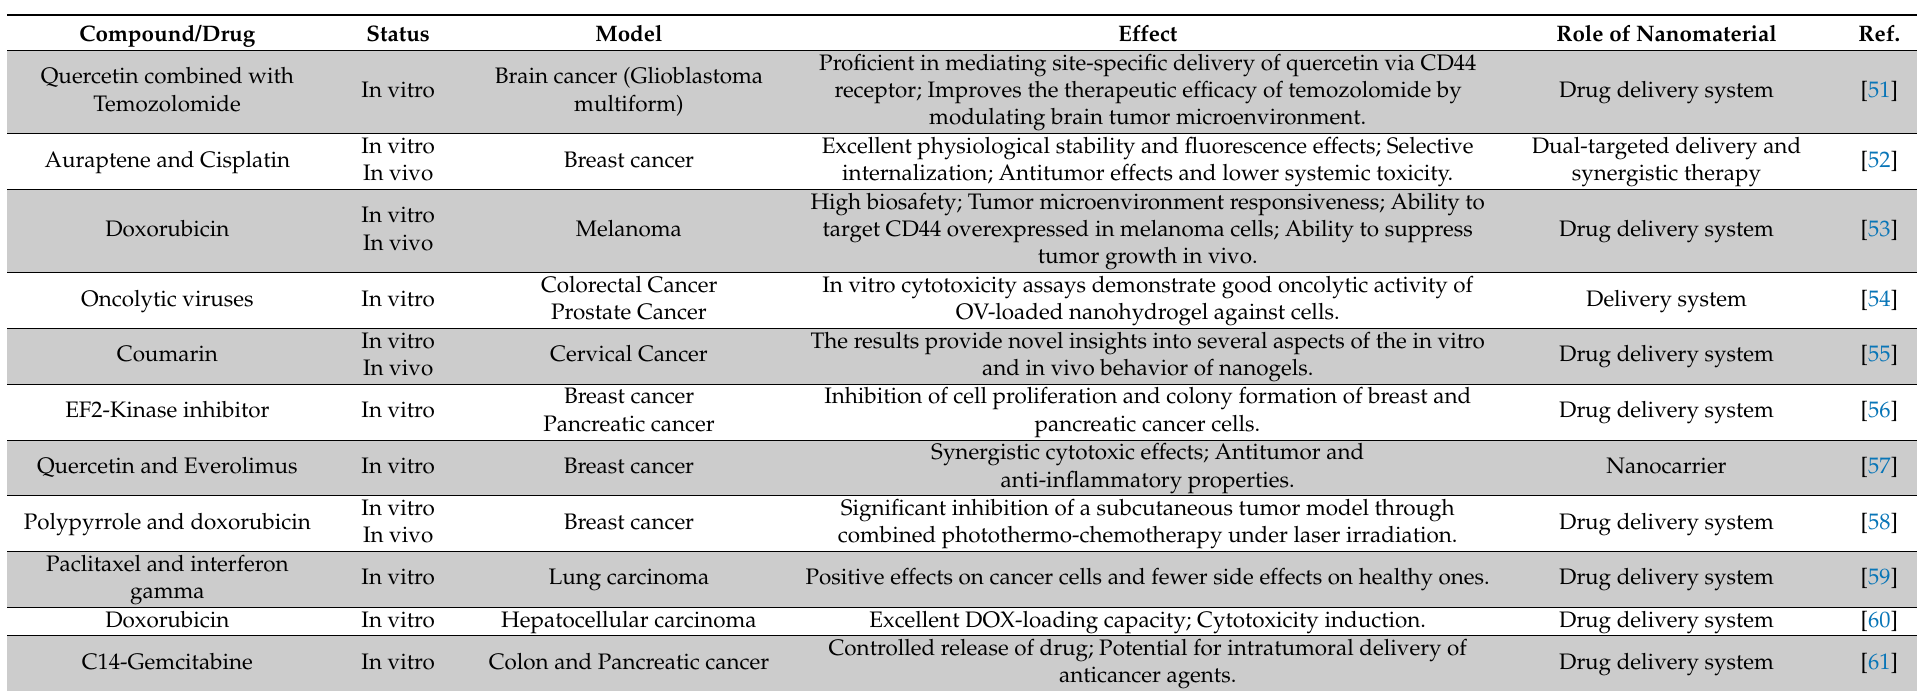
Table 2. Recent application of HA-based hydrogels in cancer